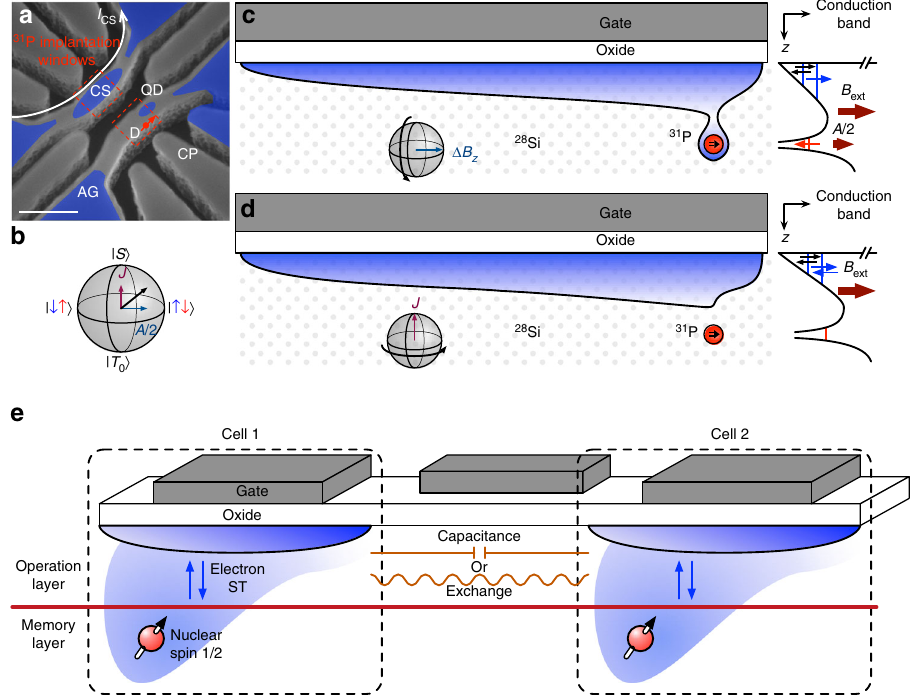
Fig. 1 Quantum dot-donor system. a Angled-view scanning electron microscope image of the device gate structure. The blue overlay represents the 2D electron gas at the Si-oxide interface. Donors are implanted in the regions designated by the dashed red lines. The relevant donor (D) located next to the quantum dot (QD) is indicated by the red dot. Scale bar: 200 nm. b A four-electron fi lled-shell con fi guration is used to mimic a two-electron singlet-triplet qubit (see main text for details). The Bloch sphere shows the logical singlet S j i ¼ "#j i (cid:2) #"j i and triplet T 0 j i ¼ "#j i þ #"j i qubit states at the poles. Electrical voltages adjust the relative magnitudes of J and A /2: J is dominant in the (4, 0) charge con fi guration, while A /2 is in the (3, 1) con fi guration. c S chematic showing the electrons con fi ned in the (3, 1) con fi guration at the Si-oxide interface in a large tunable QD and separated by a valley splitting, together with the relatively small D potential. The hyper fi ne interaction with the 31 P nucleus makes the electrons precess at different rates, creating an effective magnetic fi eld difference Δ B z = ± A /2 between the QD and the D. d The donor electron can be moved to the QD using gate voltages. In this (4, 0) con fi guration, the exchange interaction dominates. e Conceptual view of how a coupled QD and D cell could interact with other elements in a future chip. The electron qubit (blue arrows) is well suited for fast operations and readout. The nuclear spin qubit has high coherence and fi delity. Thanks to the large engineered QD, the electron qubits could be coupled through capacitive or exchange interaction without requiring atomic precision in the placement